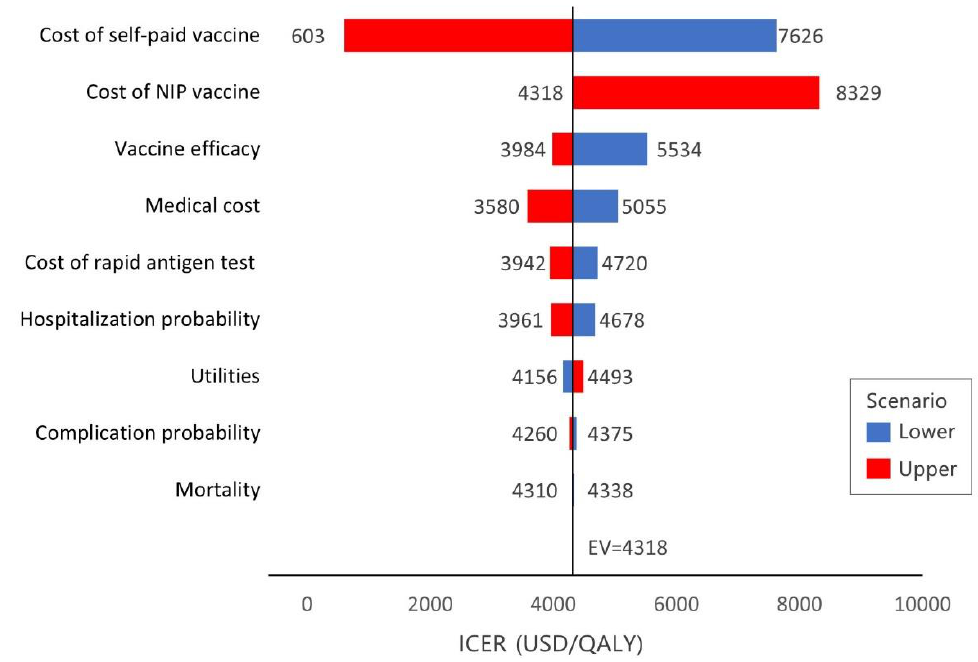
Figure 2. Tornado diagram of deterministic sensitivity analysis (healthcare sector perspective). Tornado diagram showing an increase (red) or decrease (blue) of other parameters for the lower and upper limits of the healthcare perspectives; EV, expected value; ICER, incremental cost-effectiveness ratio; QALY, quality-adjusted life years.